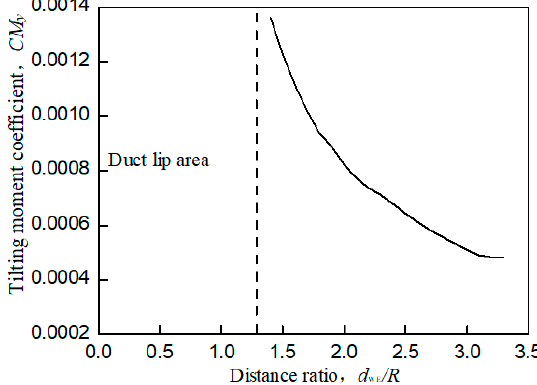
Figure 7. Tilting moment coefficient of wall effect by CFD simulations.